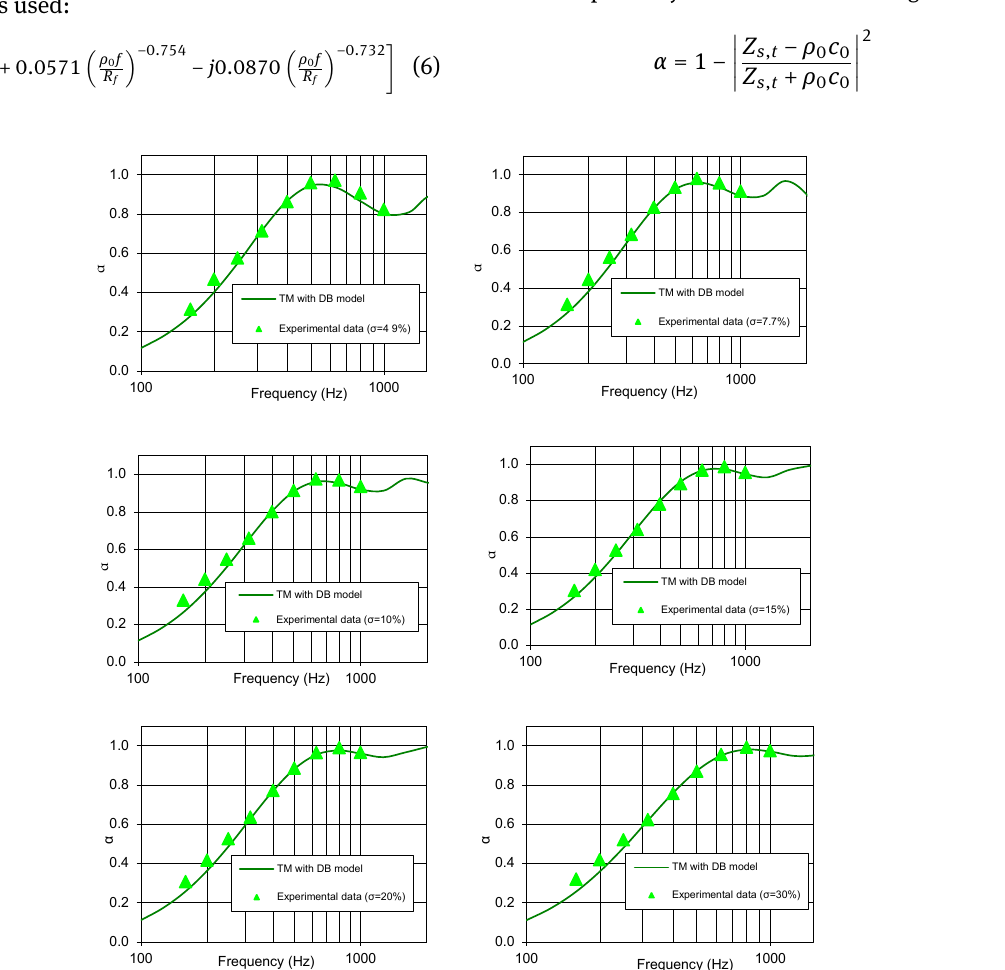
Figure 12: Experimental and predicted normalincidence sound absorption coeflcient comparison (2 mm air